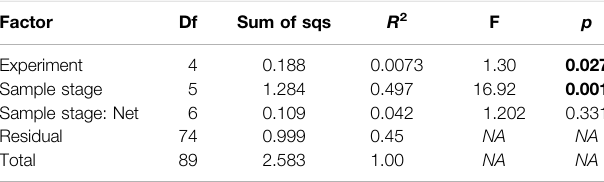
TABLE 6 | Statistics showing the results of factors: “ experiment ” , “ sample stage ” , and “ net ” nested in “ sample stage ” . Factor Df Sum of sqs R 2 F p